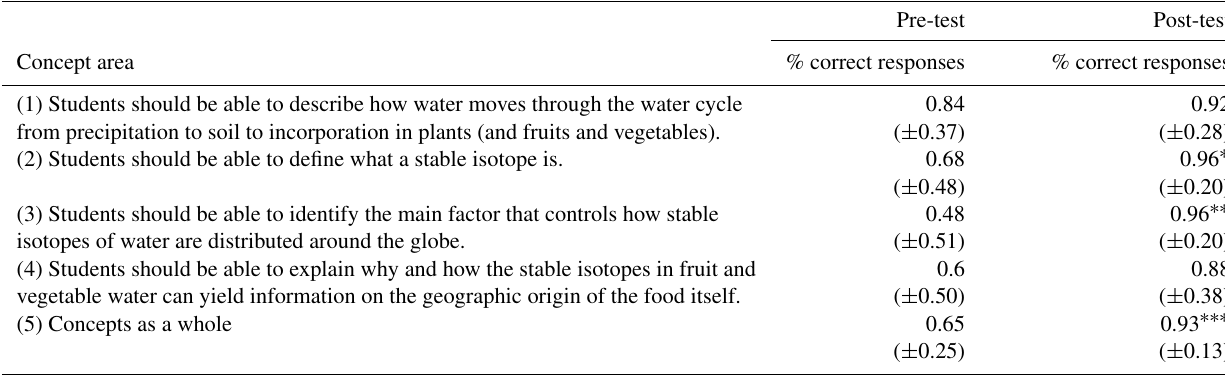
Table 2. Learning objectives with pre- and post-test assessment results. Asterisks indicate level of statistical significance ( p values) as listed below